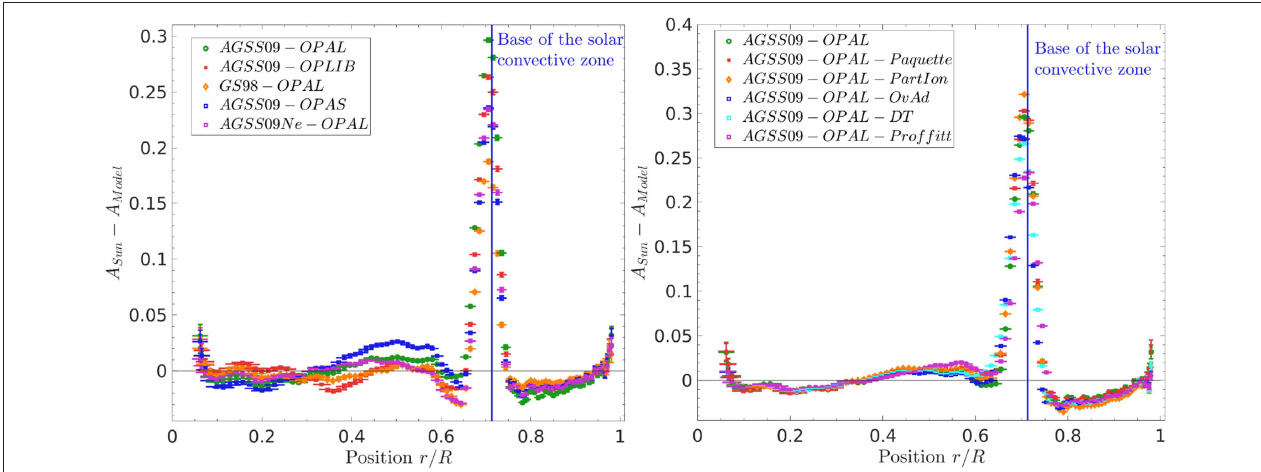
FIGURE 4 | (Left) Ledoux discriminant differences between standard solar models using various abundance and opacity tables and helioseismic results. (Right) Ledoux discriminant differences between models including various prescriptions for the mixing of the chemical elements and helioseismic results.